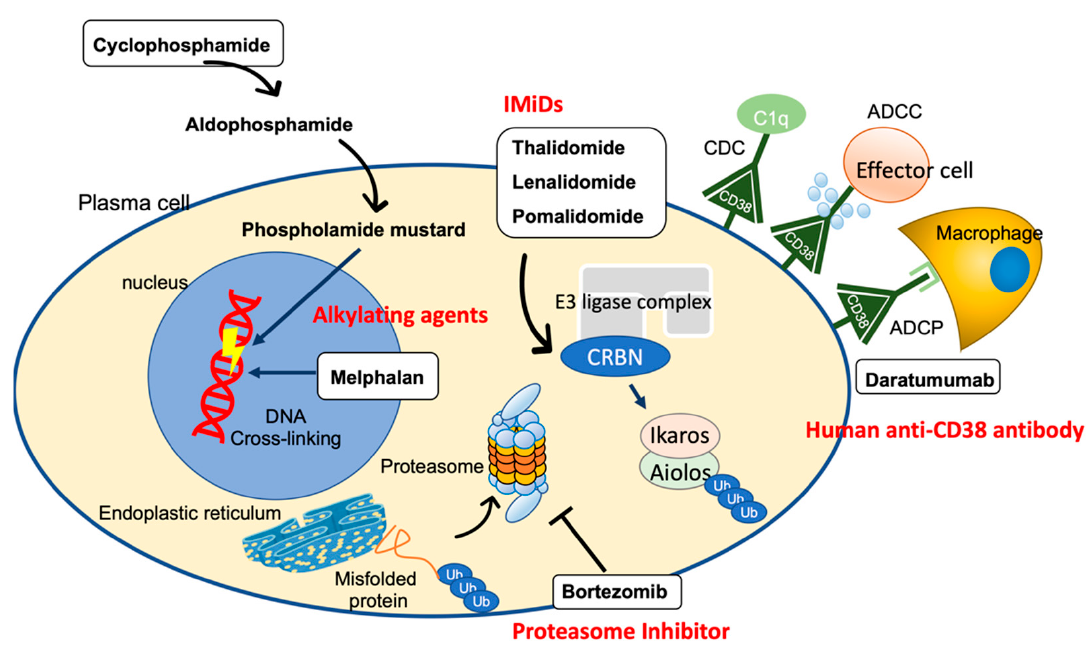
Figure 2. Targets and mechanisms of drugs used in AL amyloidosis.